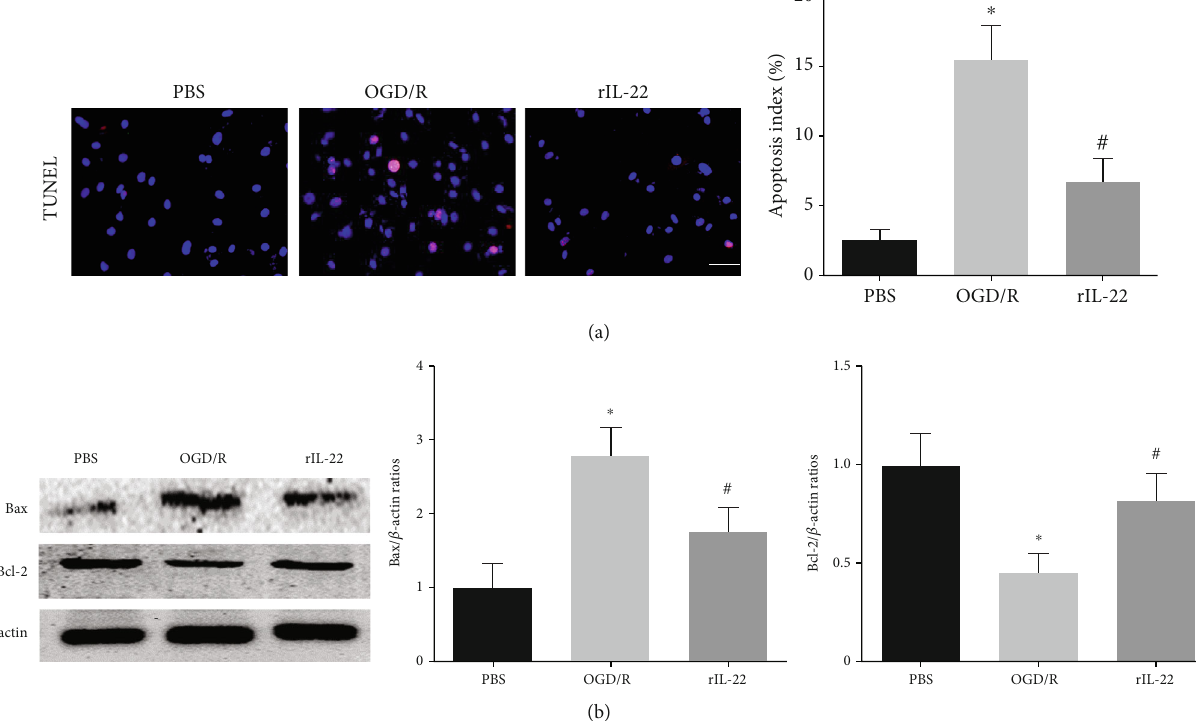
Figure 5: IL-22 treatment attenuated OGD/R-induced neuronal apoptosis. (a) Neuronal apoptosis was detected by TUNEL staining ( n = 5 , scale bar = 50 μ m). (b) The expression of Bax, Bcl-2, and β -actin was detected by western blotting ( n = 4 ). ∗ P < 0 : 05 vs. PBS group; # P < 0 : 05 vs. OGD/R